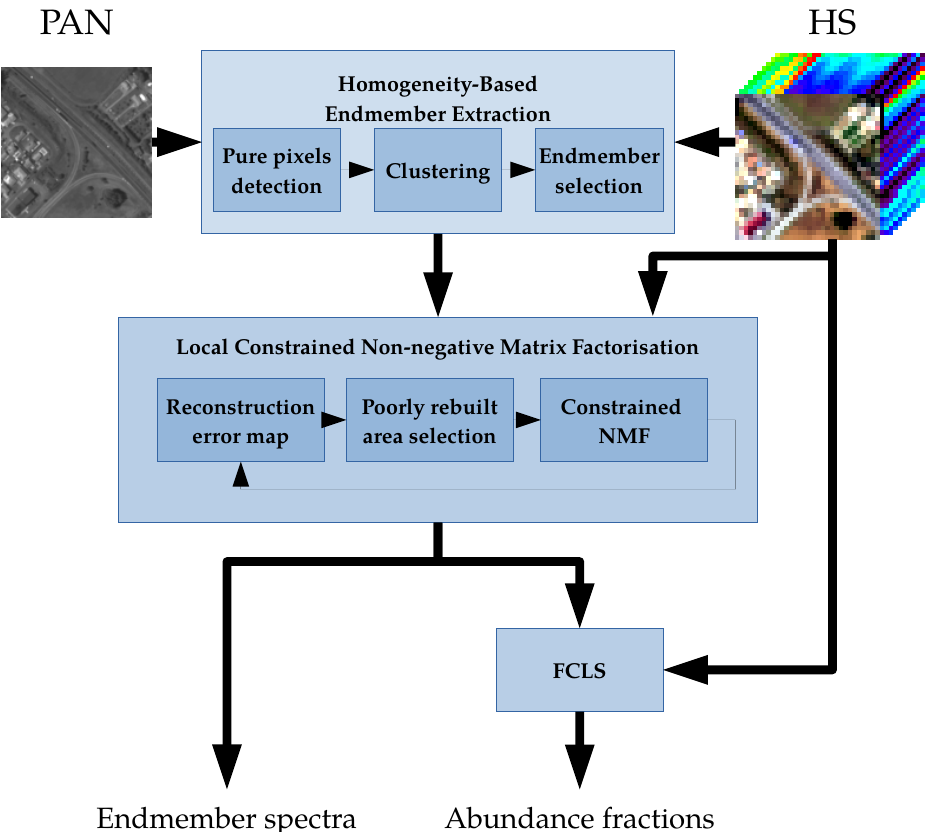
Figure 2. Overview of the proposed Local Constrained Non-negative Matrix Factorization (HBEE-LCNMF)